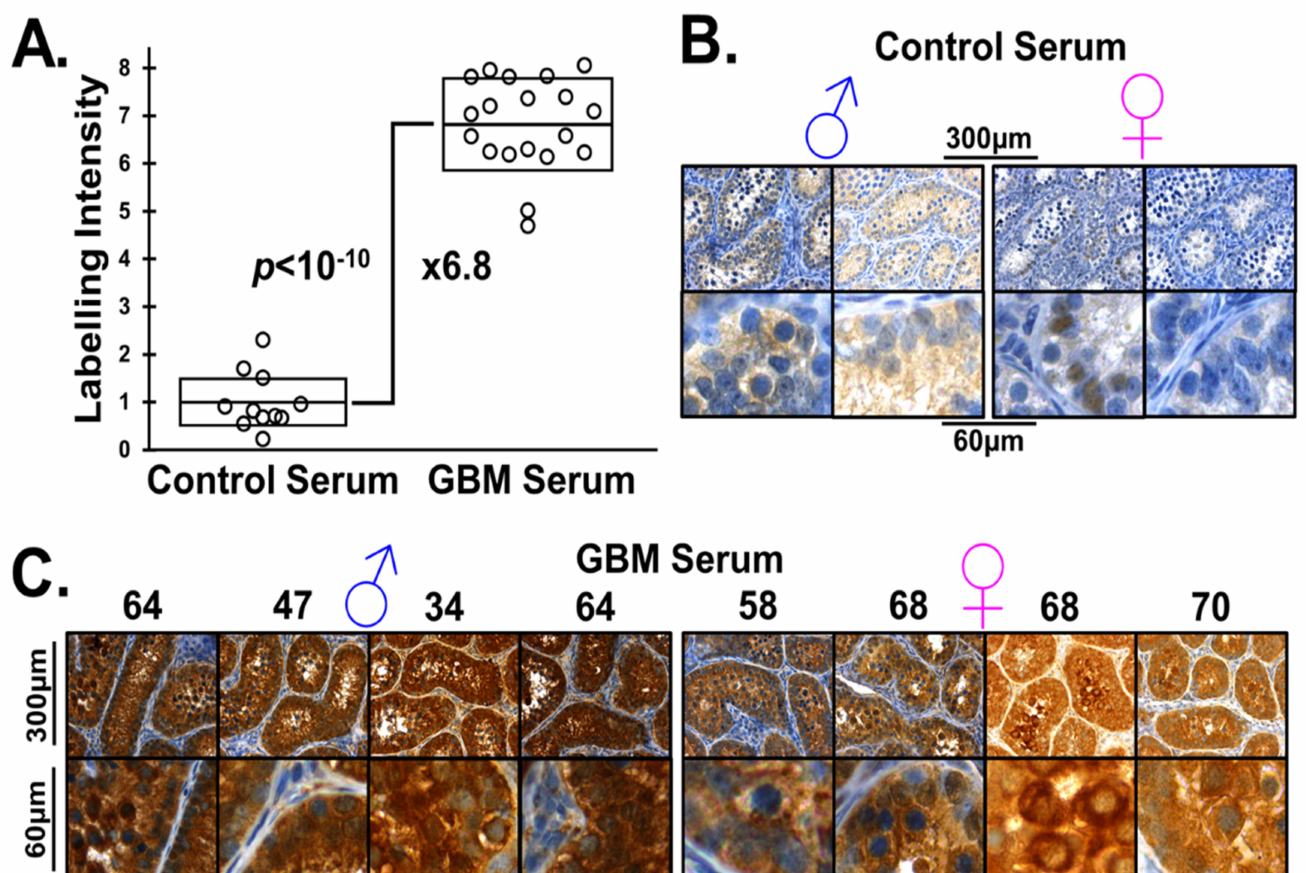
Figure 4. Monkey Testicle labeled with Patient Serum. ( A ) Staining intensity is significantly greater in the GBM than the control serum when brightness is quantified and scaled, nearly sevenfold that of the control, mean and SD boxed, p < 10 − 10 . ( B ) Labeling of Cynomolgus monkey testicle using serum from control patients. Low levels of anti- sperm/testicular antibodies, and therefore light staining can be observed. ( C ) The significant staining on Cynomolgus monkey testicle when treated with patient sera indicates the presence of antibodies to testicular germ cells and to sperm at all stages of development. Patient age is atop the